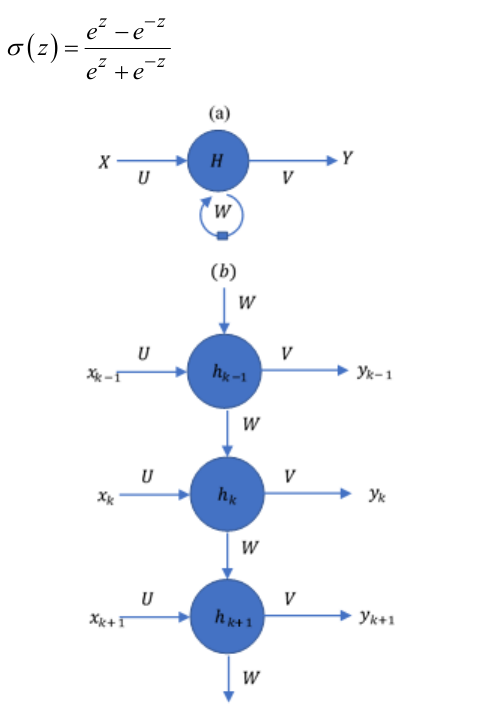
Figure 1. RNN architecture (a) Recurrent notation (b) Unrolled recurrent architecture